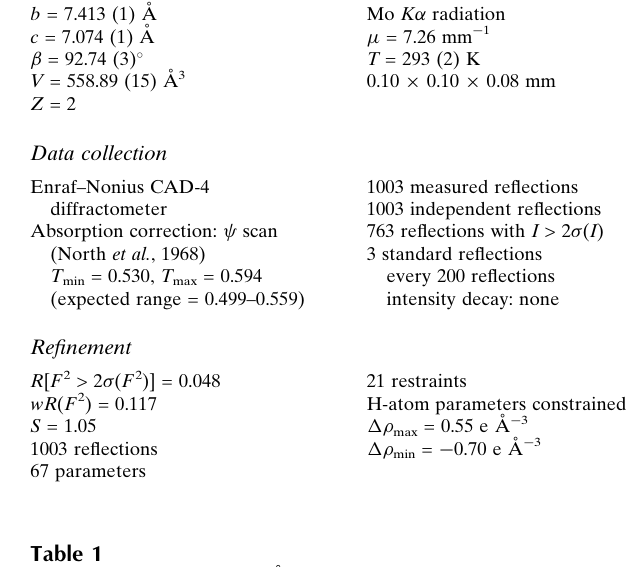
Hydrogen-bond geometry (A˚ , (cid:2)